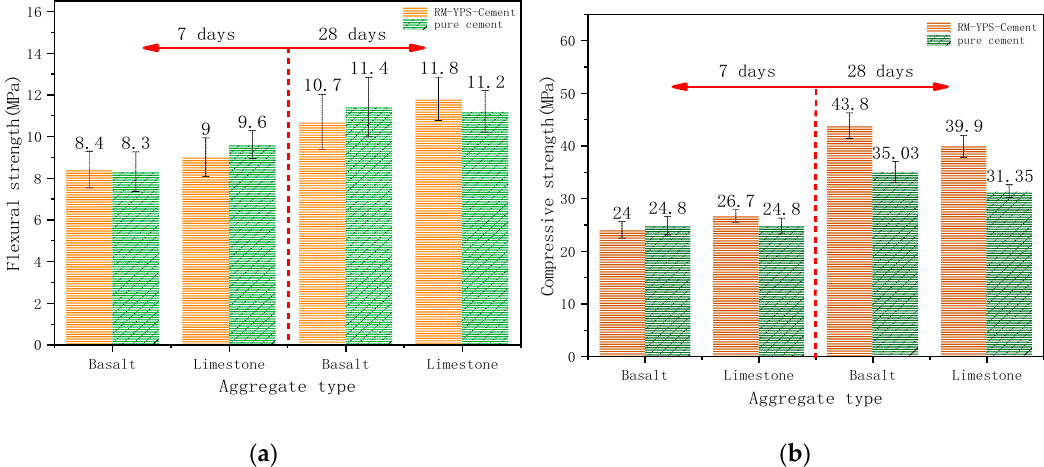
Figure 6. ( a ) Flexural strength and ( b ) compressive strength of concrete with different aggregates and RM–YPS–cement.